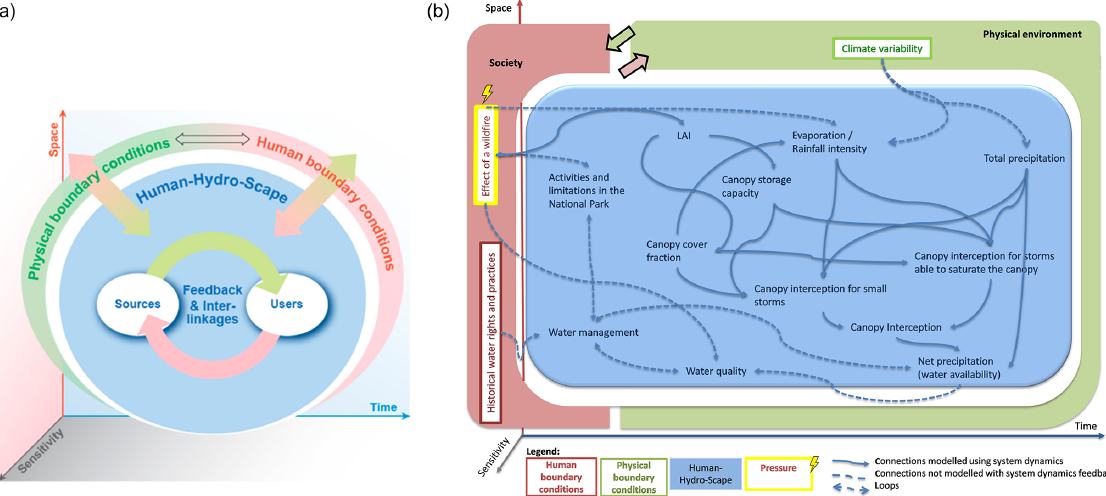
Figure 1. (a) The pluralistic water research (PWR) framework (Evers et al., 2017). (b) Representation of the key elements within the physical human-hydro-scape and human and physical boundaries to understand the effects of human-induced wildfires on rainfall interception, water availability, quality and land use based on the e-DPSIR approach for the case of La